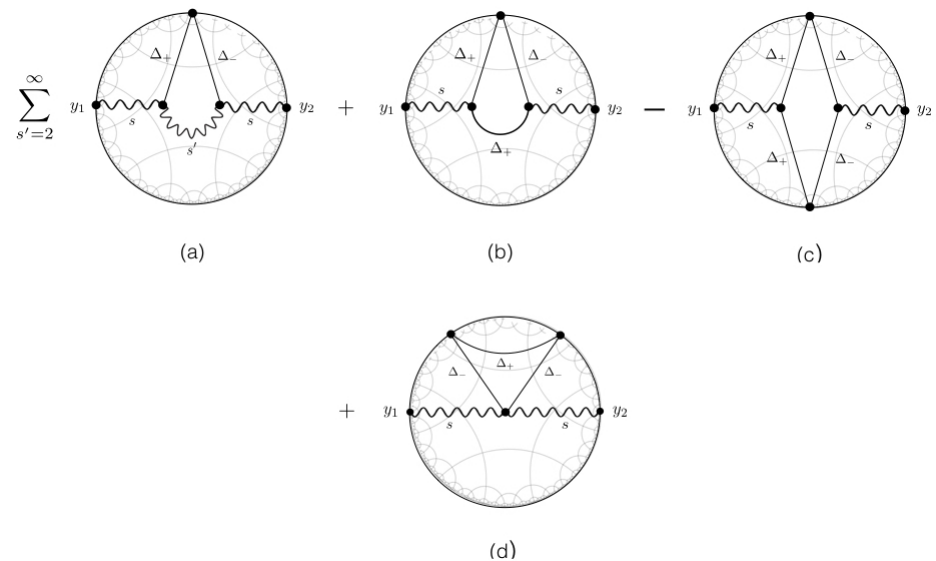
Figure 13. Diagrams which contribute to the di(cid:11)erence M (cid:1) + ; total 1-loop s ( y 1 ; y 2 ) (cid:0) M (cid:1) (cid:0) ; total 1-loop s ( y 1 ; y 2 ) of two-point one-loop amplitudes for the (cid:1) + and (cid:1) (cid:0) boundary conditions on the bulk scalar. Diagrams (a)-(c) on the (cid:12)rst line were computed in section